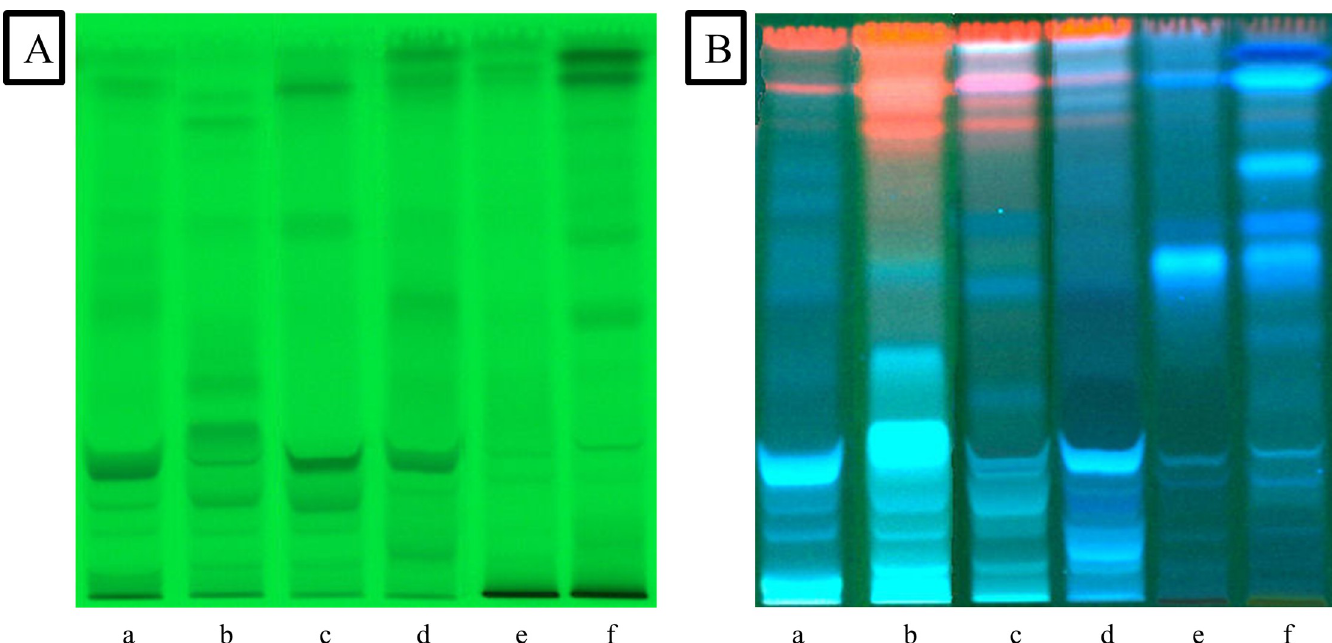
Fig 1. HPTLC chromatograms of (a) R . officinalis , (b) S . sclarea , (c) O . vulgare , (d) T . longicaulis , (e) C . creticus and (f) C . monspeliensis at 254 nm ( A ) and 366 nm ( B ) (mobile phase dichloromethane, methanol, water (70:30:4; v/v/v)).